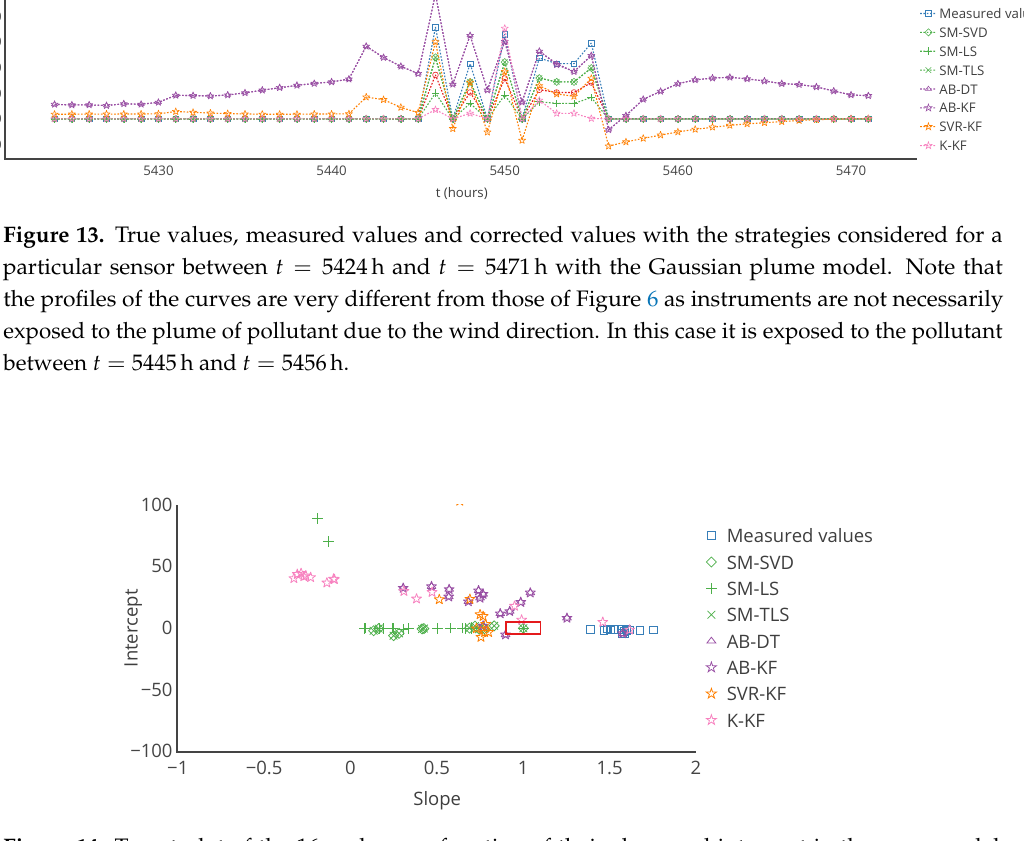
Figure 14. Target plot of the 16 nodes as a function of their slope and intercept in the error model, computed on the entire time interval of drift, for each calibration strategy and with the Gaussian plume model. The instruments are not all present, notably for those after the correction by SVR-KF. Axis were truncated to keep the plot readable. The red rectangle depicts the same requirement as in Figure 11 for example, a slope in [ 0.9;1.1 ] and an intercept in [ − 5;5 ] . Few instruments are inside this area